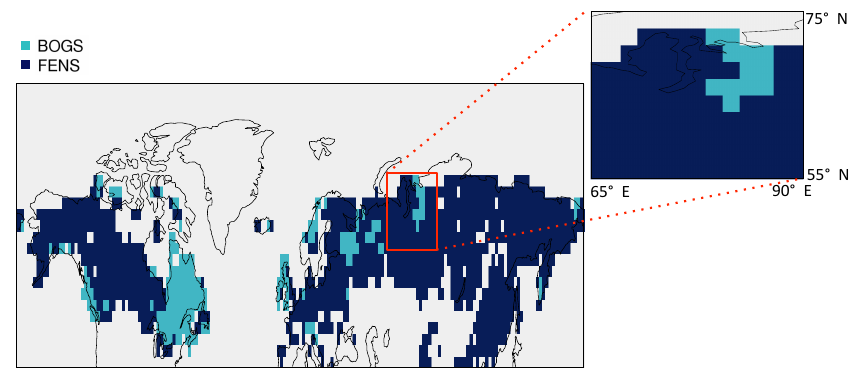
Figure 6. Map of northern peatlands separating the type of bogs (light blue) from fens (dark blue) modelled peatlands based on conditions of the water table depth (WTD) fed by the precipitation only. The region of western Siberia (zoomed area) has been used for a sensitivity study of peatland to precipitation.